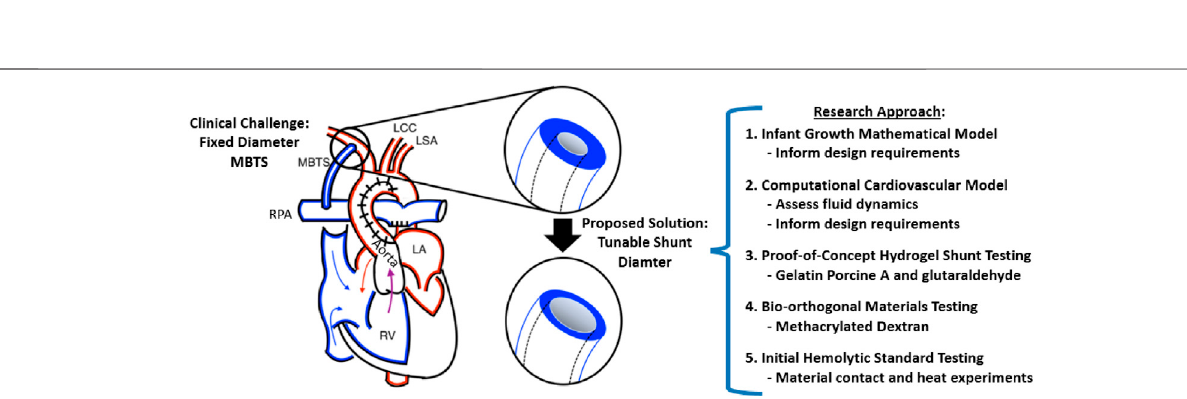
Frontiers in Bioengineering and Biotechnology |